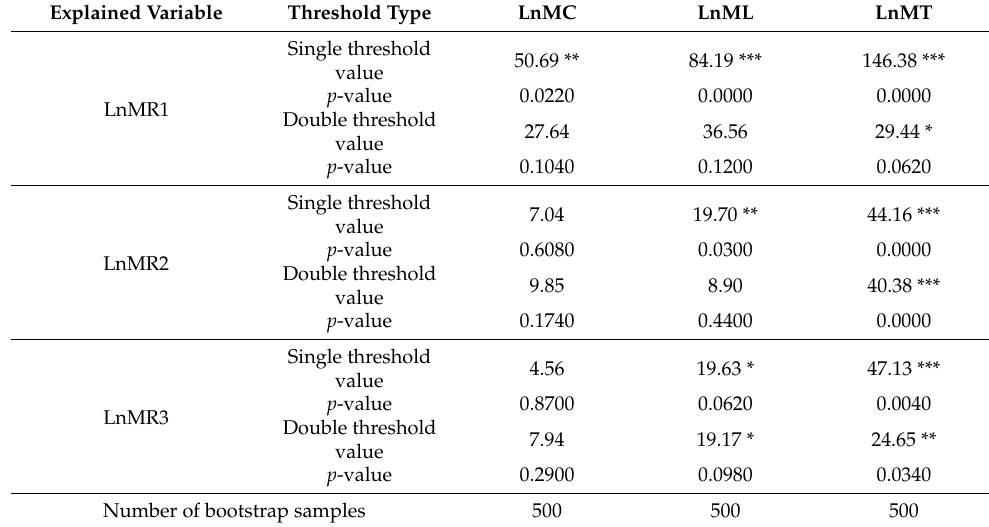
Table 4. Marine resources and economic growth threshold